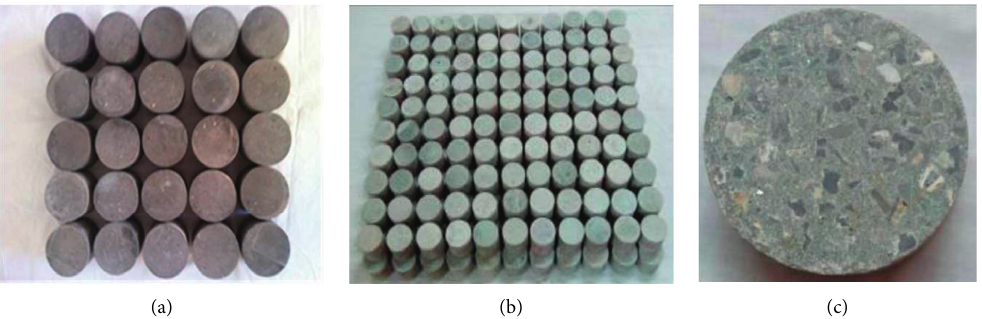
Figure 2: Concrete specimens (74mm diameter, 70mm height cylinder). (a) Specimens of desert sand concrete. (b) Specimens of ordinary concrete. (c) Specimens after grinding.